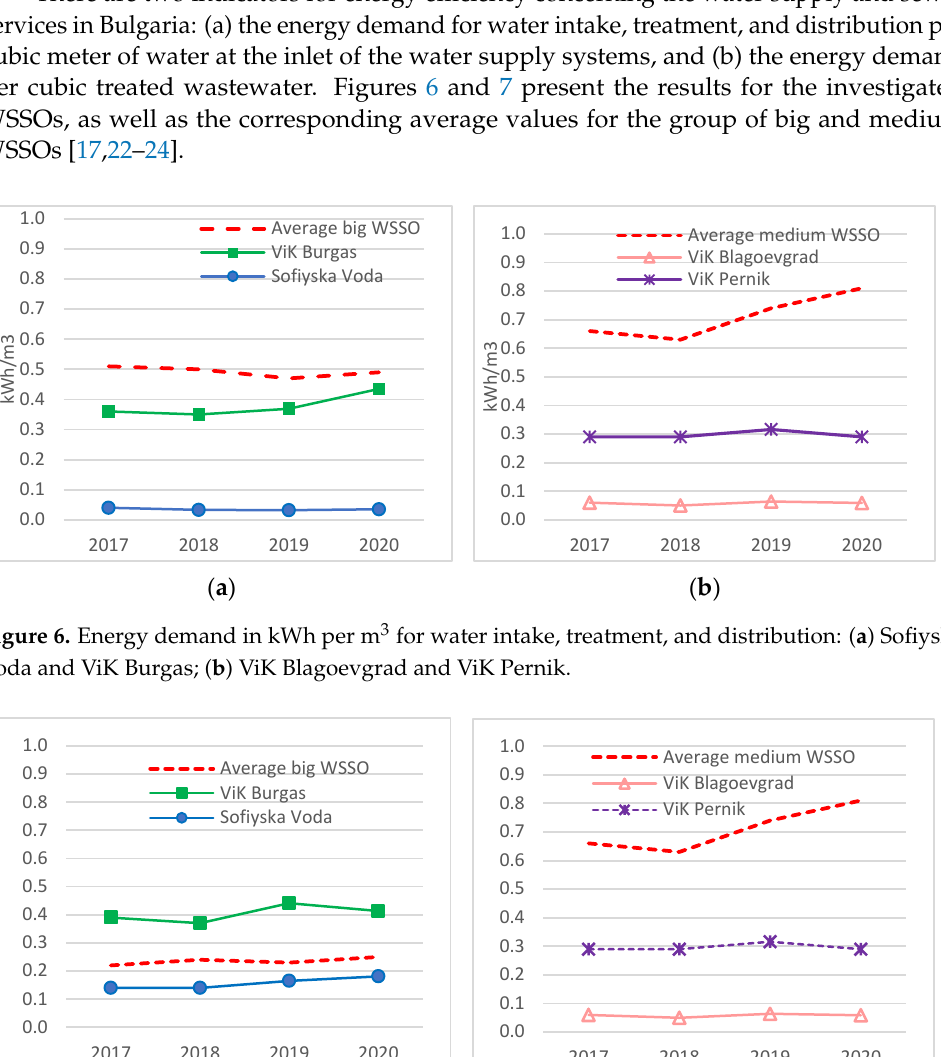
Figure 7. Energy demand in kWh per m 3 treated wastewater: ( a ) Sofiyska Voda and ViK Burgas; ( b ) ViK Blagoevgrad and ViK Pernik .